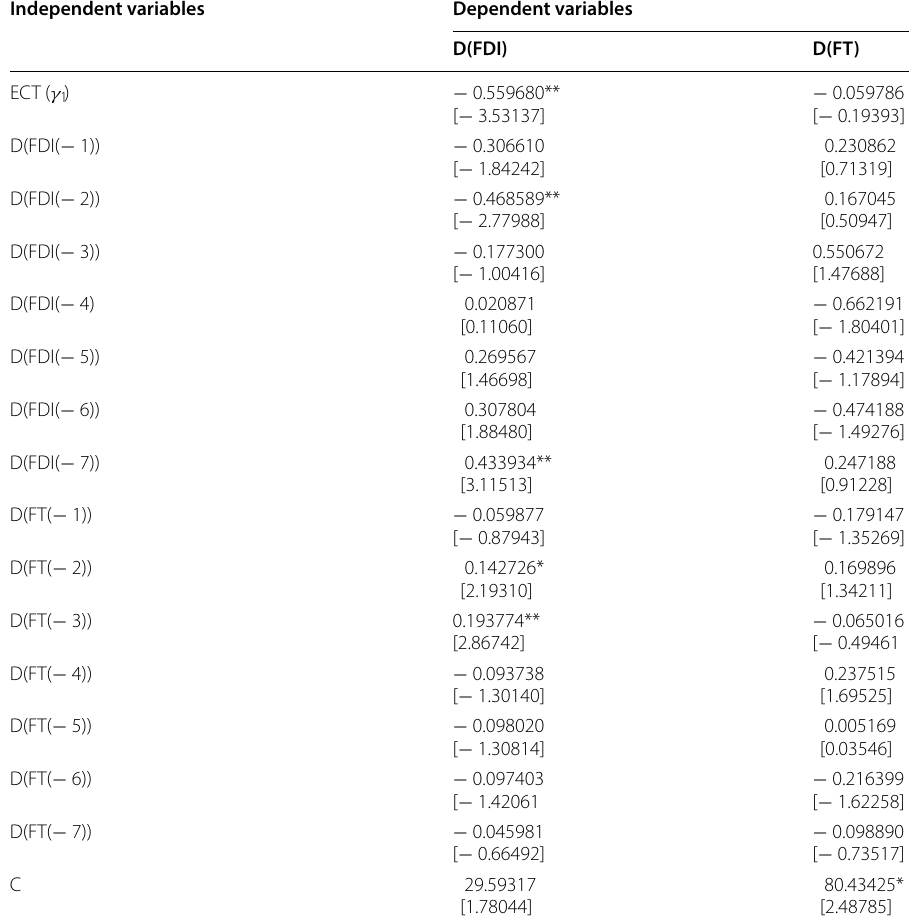
Table 7 Results of vector error correction model for FDI and FT. Source: Calculated by authors